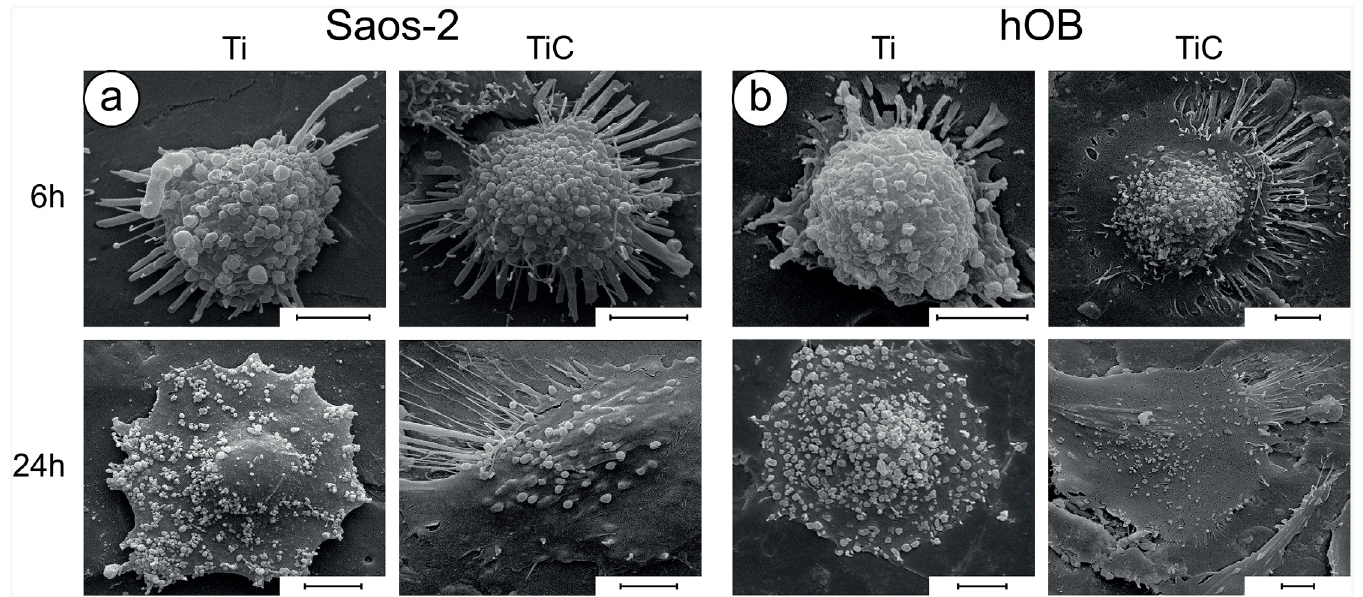
Fig 6. Investigation of cell morphology by SEM. Panel a: SEM micrographs showing the morphology of Saos-2 cells grown for 6h and 24h on uncoated (Ti) and TiC coated (TiC) titanium disks. Panel b: similar analysis on hOB cells. The images reveal that both types of cells are richer in philopodia and lamellipodia and better adhered to the substrate when grown either for 6 or 24 hrs on the TiC coated titanium disks compared to the uncoated. In each figure, the bars represent 5 μ